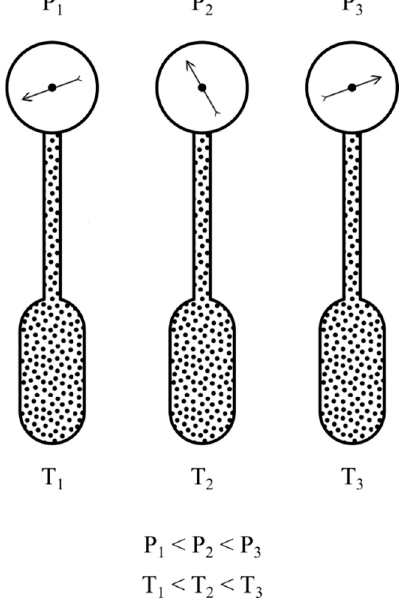
Figure 2. Gas thermometer at three different temperatures.